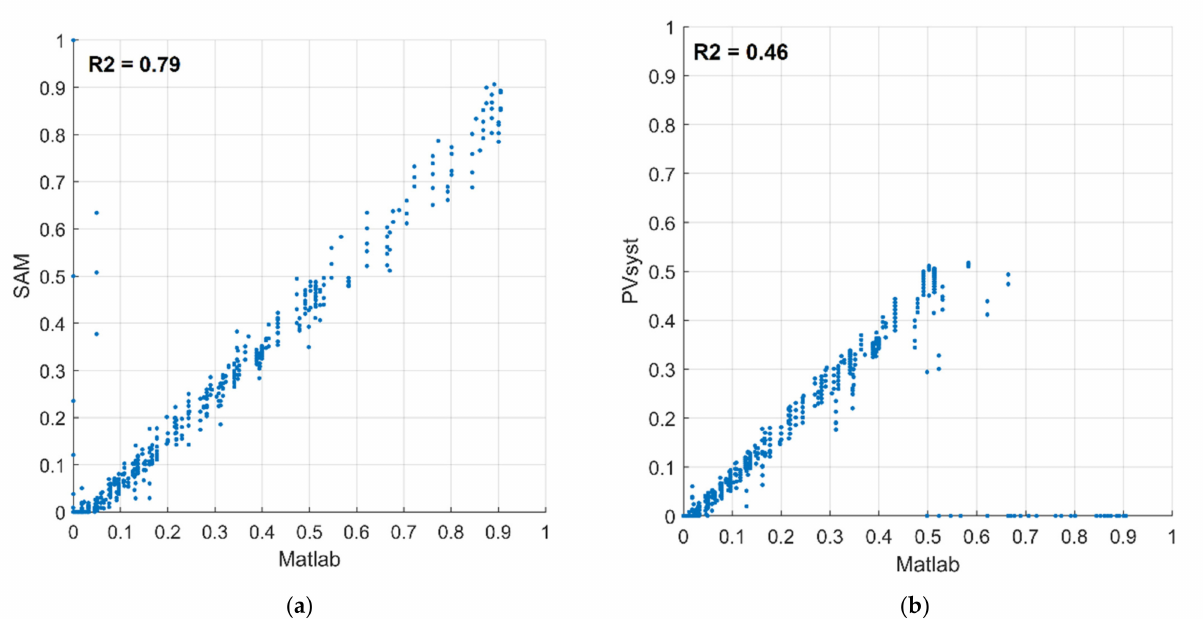
Figure 20. Scatter plots for the direct irradiance shading factor f B . Comparison of: ( a ) Matlab with SAM and ( b ) Matlab with PVsyst. Results are for situation 2, one module shaded by one infinite